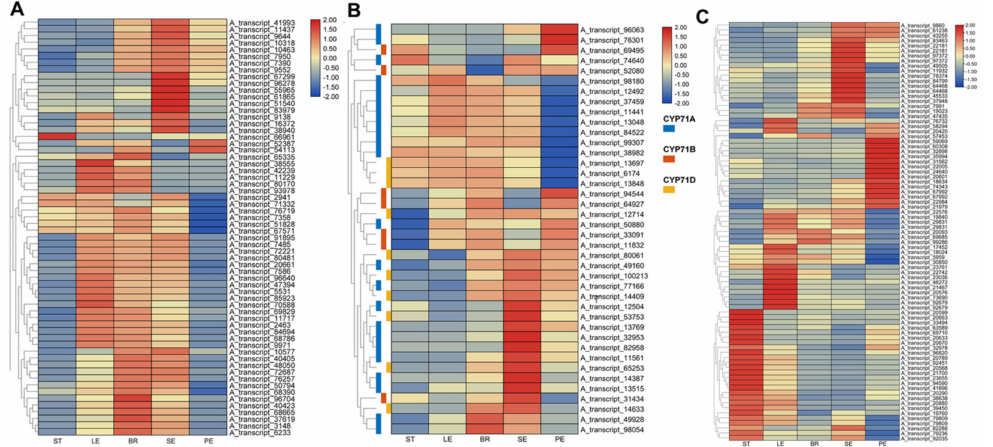
Figure 4. The expression pattern analysis of genes associated with terpene synthases (TPSs), cy- tochromes P450s (CYPs), and short-chain dehydrogenase/reductases (SDRs). Heatmap of expression profiles of TPS ( A ), CYP71 ( B ), and SDR ( C ) genes in different tissues of Origanum vulgare ‘Hot and